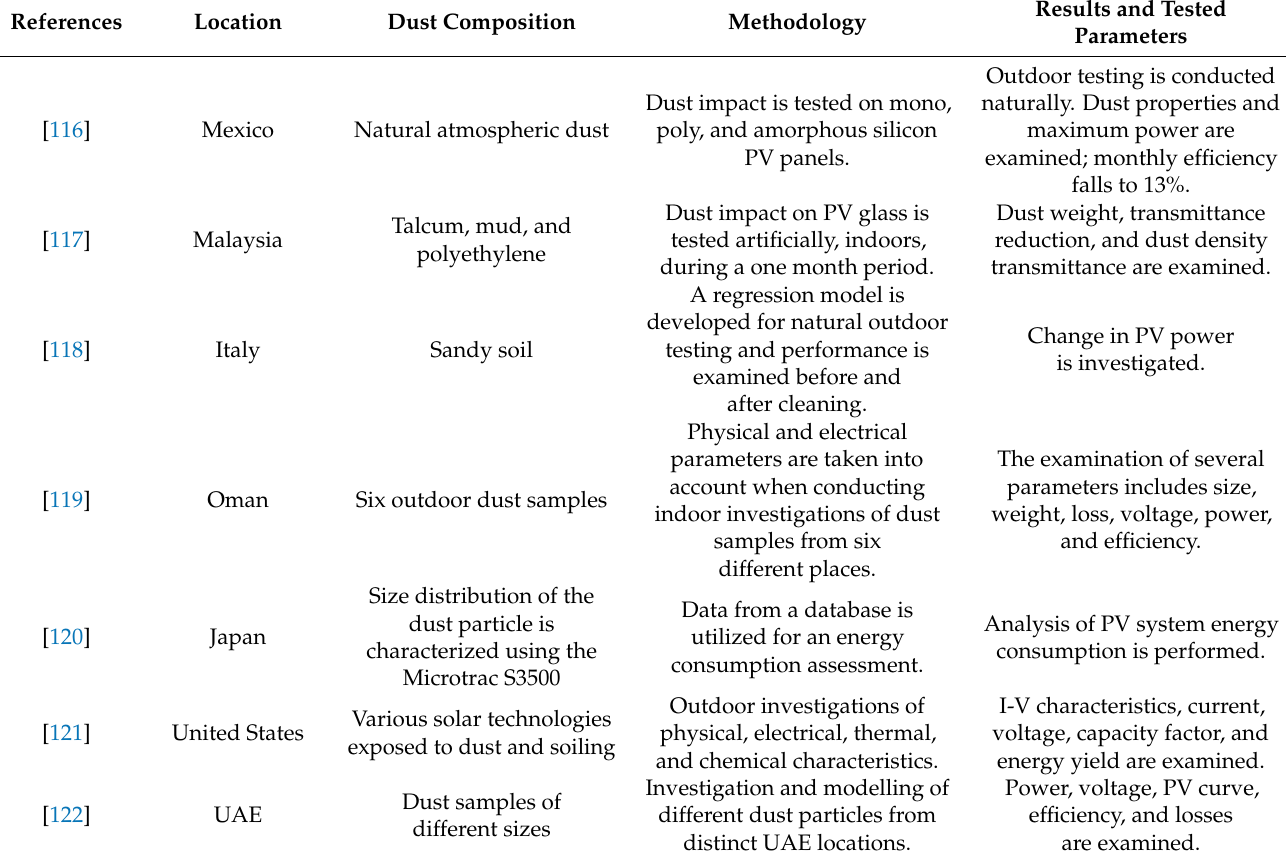
Table 7. Summary of the literature that concerns the impact of dust on PV